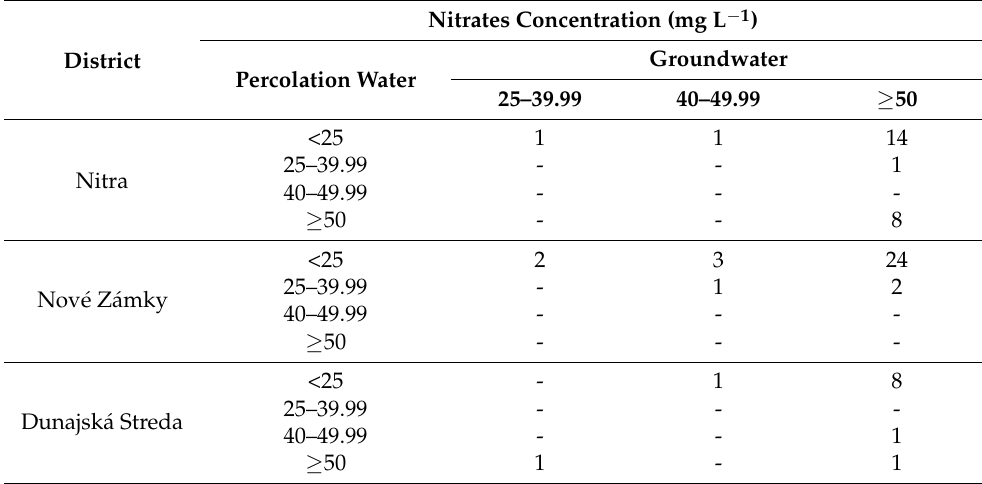
Table 5. Number of groundwater monitoring sites corresponding to combinations of average annual nitrate concentration in seepage water and groundwater.